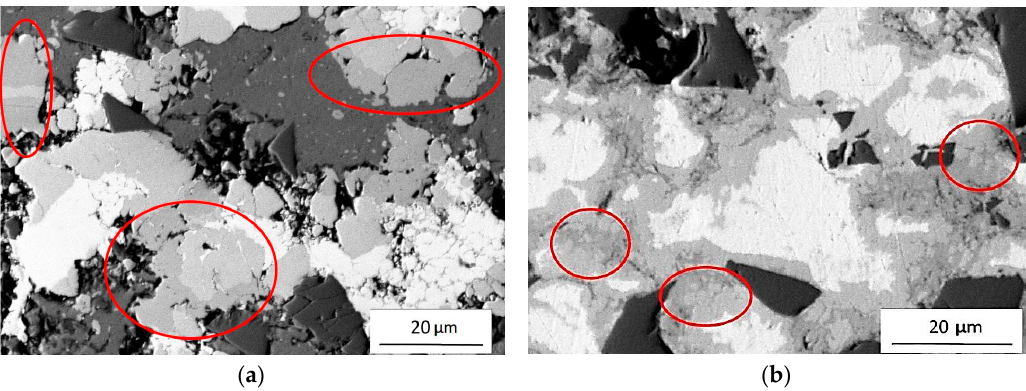
Figure 10. Intermetallics formation in the center ( a ) and at the boundary ( b ) of weld in 49% Al coating heated by resistance spot welding process with parameters No. 4.